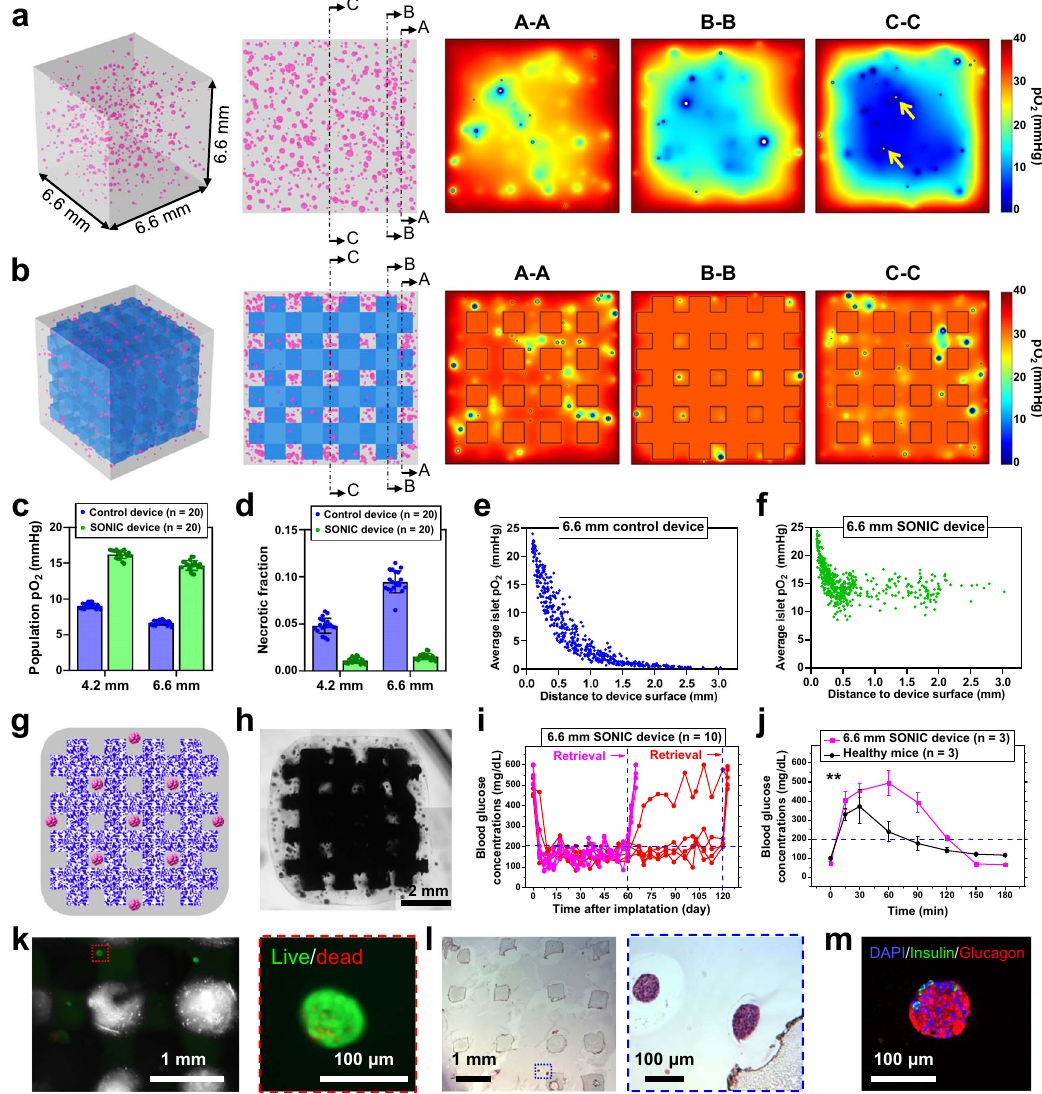
Fig. 6 Demonstration of the therapeutic potential of a thick SONIC device. a , b Schematics representing the simulated geometry for a thick control device ( a ) and thick SONIC device (6.6 × 6.6 × 6.6 mm) ( b ) containing rat islets (size-distributed). Simulation-predicted pO 2 distributions of the control device in three cross-sections (labeled A-A, B-B, and C-C) showing a massive hypoxic central region, with necrosis observed even in some small islets (arrows in C-C cross-section). However, the islets were well-oxygenated throughout the SONIC device with negligible necrosis. c , d Average pO 2 ( c ) and the fraction of necrosis ( d ) in the islet populations in control devices ( n = 20) and SONIC devices ( n = 20) at the size of 4.2 mm and 6.6 mm, mean ± SD. e , f Scatter plots of islet location versus average pO 2 of islets (generated as all 150 µ m in diameter) in the thick control device ( e ) and thick SONIC device ( f ). g , h Schematic ( g ) and microscope image ( h ) of rat islets encapsulated in a thick cubic SONIC device with a side length of ~6.6 mm. One representative of 5 replicates is shown. i BG measurements of diabetic C57BL6/J mice following IP transplantation of the 6.6 mm SONIC devices (pink, n = 5, retrieved on day 60; red, n = 5, retrieved on day 123). j IPGTT on day 58; mean ± SD; ** p = 0.0066 (two-way ANOVA). k Live/dead staining of islets from a retrieved device on day 120. l , m H&E ( l ) and immunohistochemical staining ( m ) of retrieved devices on day 120 showing morphology-intact and insulin/glucagon- positive islets. One representative of 5 replicates is